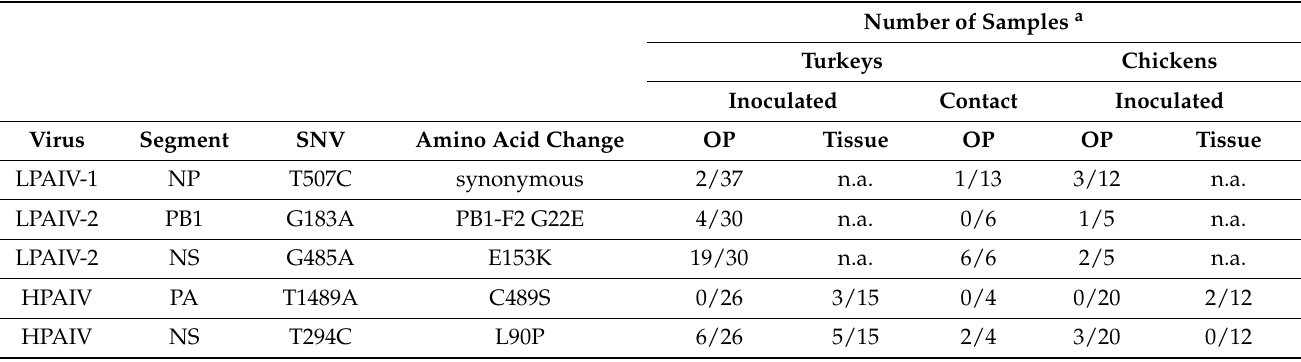
Table 2. The iSNVs at frequency greater than or equal to 50% and are found in at least one sample from turkeys and